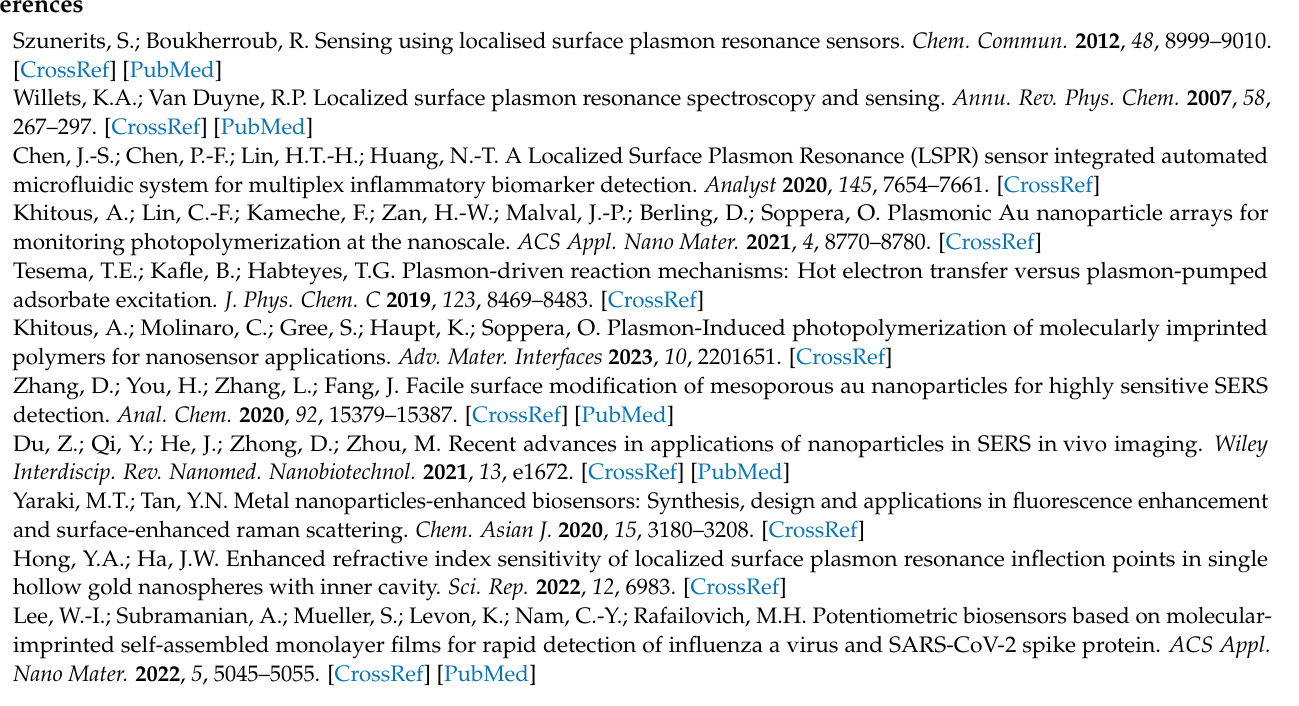
R6G at different concentrations. Figure S4: SERS spectra of AuNPs, AuNPs@MIP-R6G after synthesis and washing. Figure S5: SERS spectra of AuNPs@MIP-R6G after 10 incubations in R6G at 500 pM. Figure S6: Molecular structures of: methylene blue (MB), rhodamine 6G (R6G) and rhodamine 110